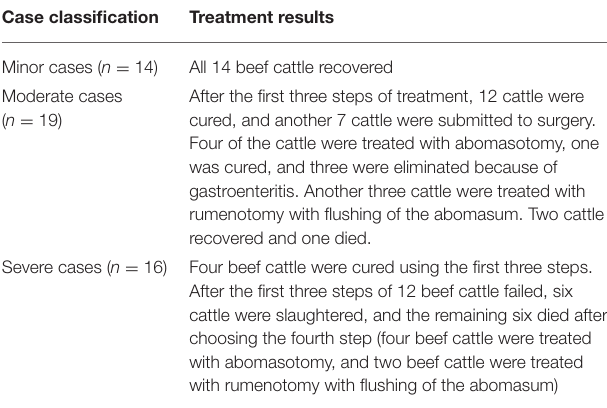
TABLE 3 | Treatment results of 49 beef